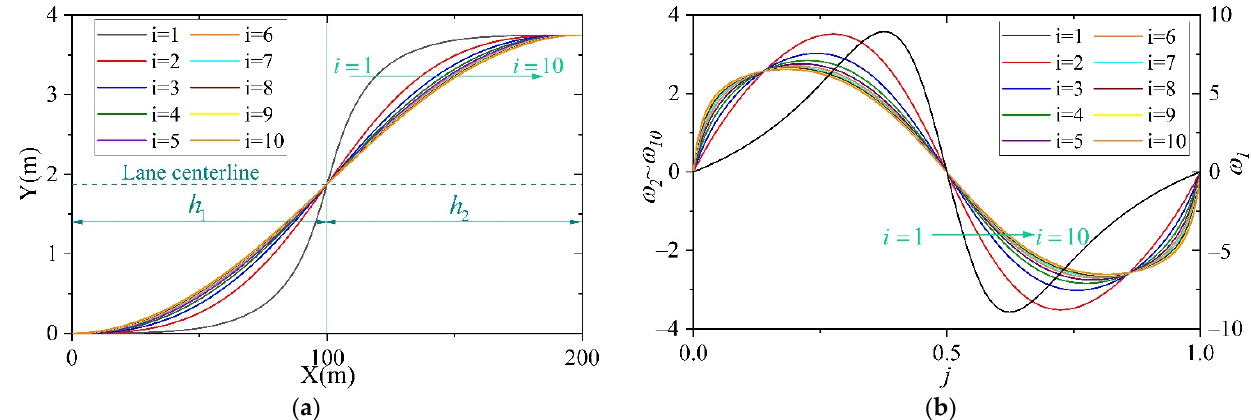
Figure 7. Influence of different i values on lane-changing path. ( a ) Comparison of driving path. ( b ) Comparison of yaw rate.